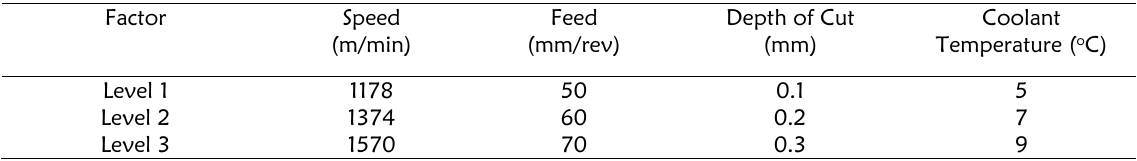
Table 1: Control factors and their levels for dry and cooled